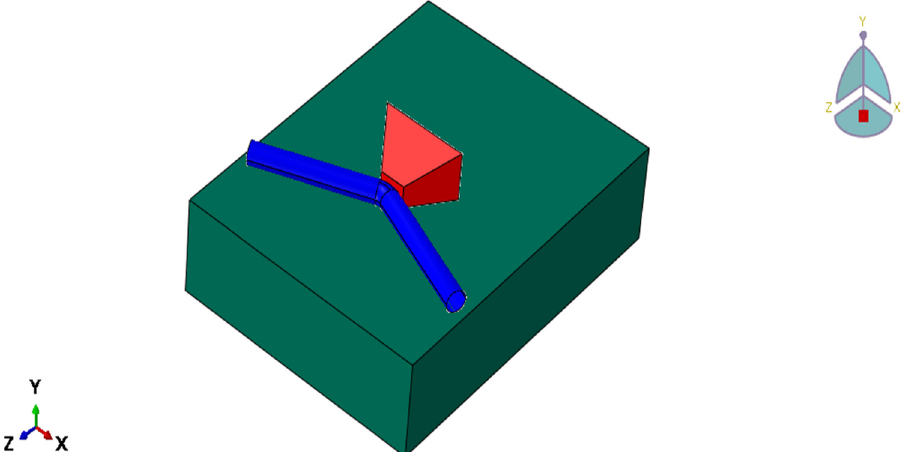
Figure 5: General view of Case 1.